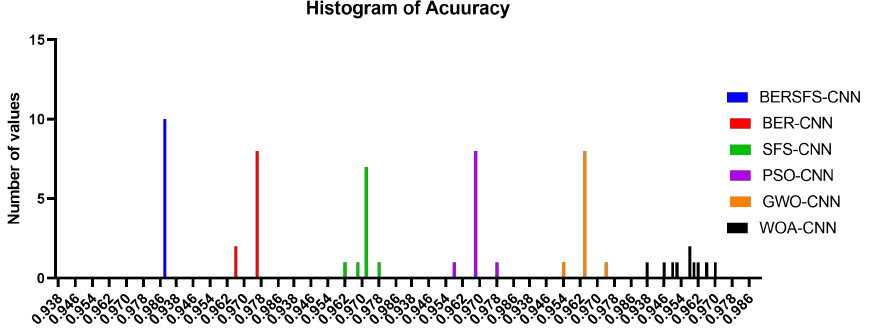
Figure 5. The box plot of the accuracy of the proposed BERSFS-CNN and comparison approaches.